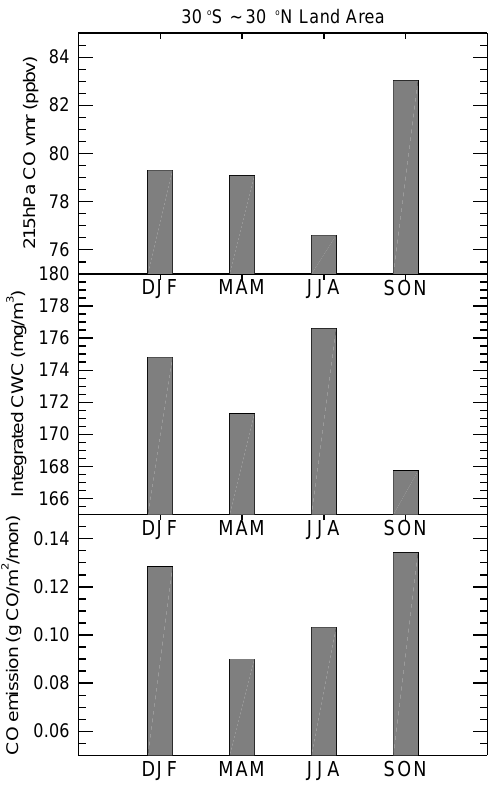
Fig. 1. Seasonal averages of MLS CO at 215hPa (top), CloudSat cloud water content (CWC) vertically integrated above 6km (mid- dle), and GFED3 surface CO emission (bottom) over the tropical land area (30 ◦ S–30 ◦ N) during December 2006–November 2007. The MLS CO values at 215hPa have been scaled by 0.5 to compen- sate for the high